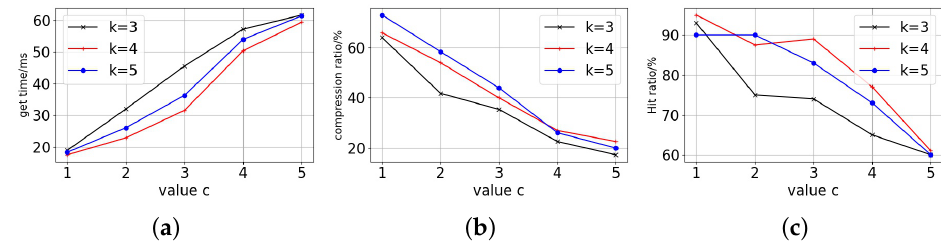
Figure 9. Particion node = 10. ( a ) Get time. ( b ) Replica data compression. ( c ) Hit ratio.